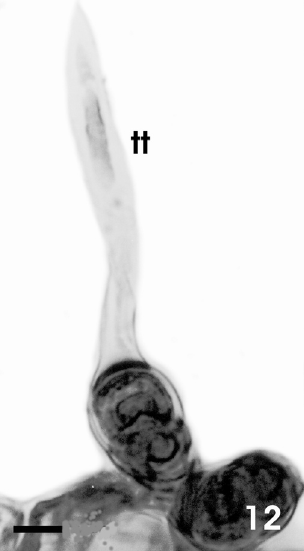
FIGURA 12 – B. microcephala – Detalhe do tricoma tector (tt). Barra = 10 µ m.